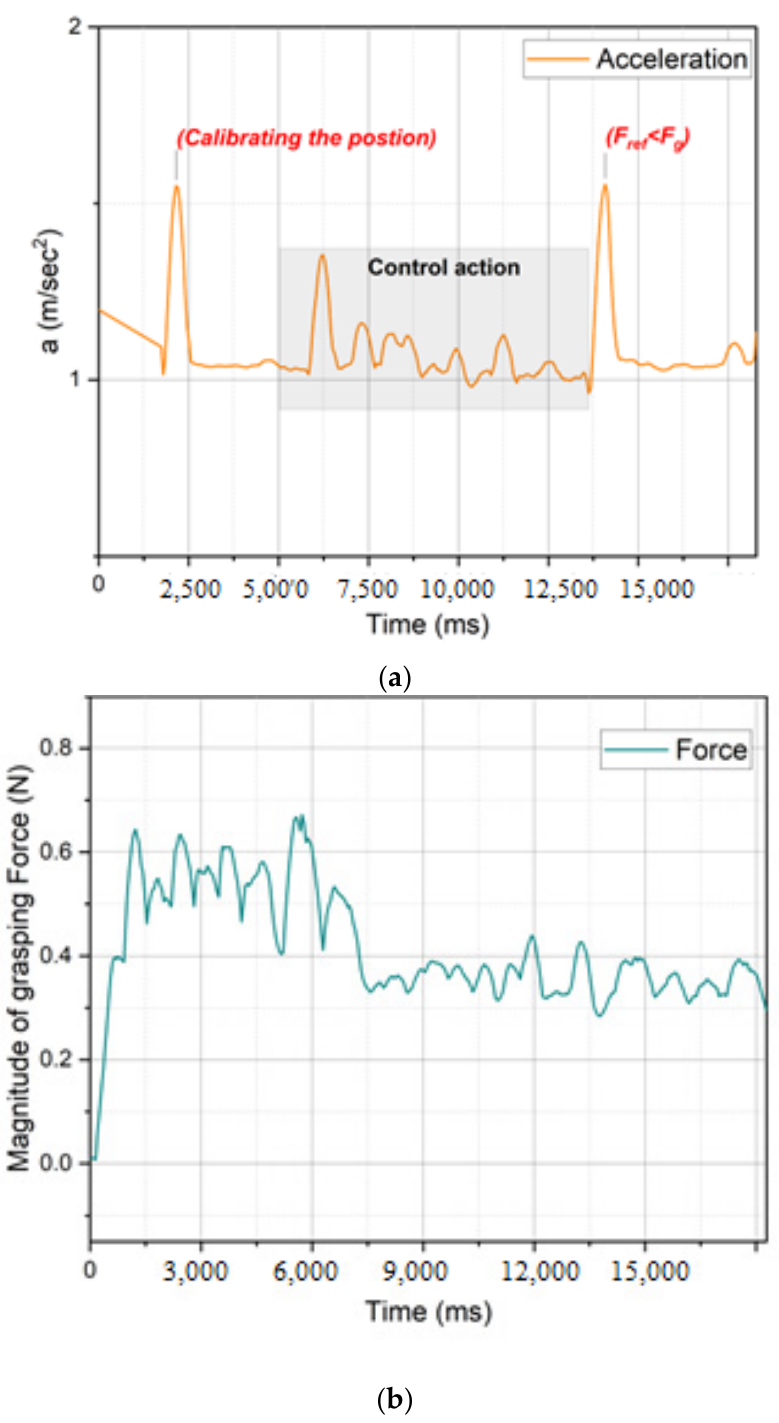
Figure 9. The characteristic results of the grasping test: ( a ). magnitude of acceleration, ( b ). magnitude of grasping